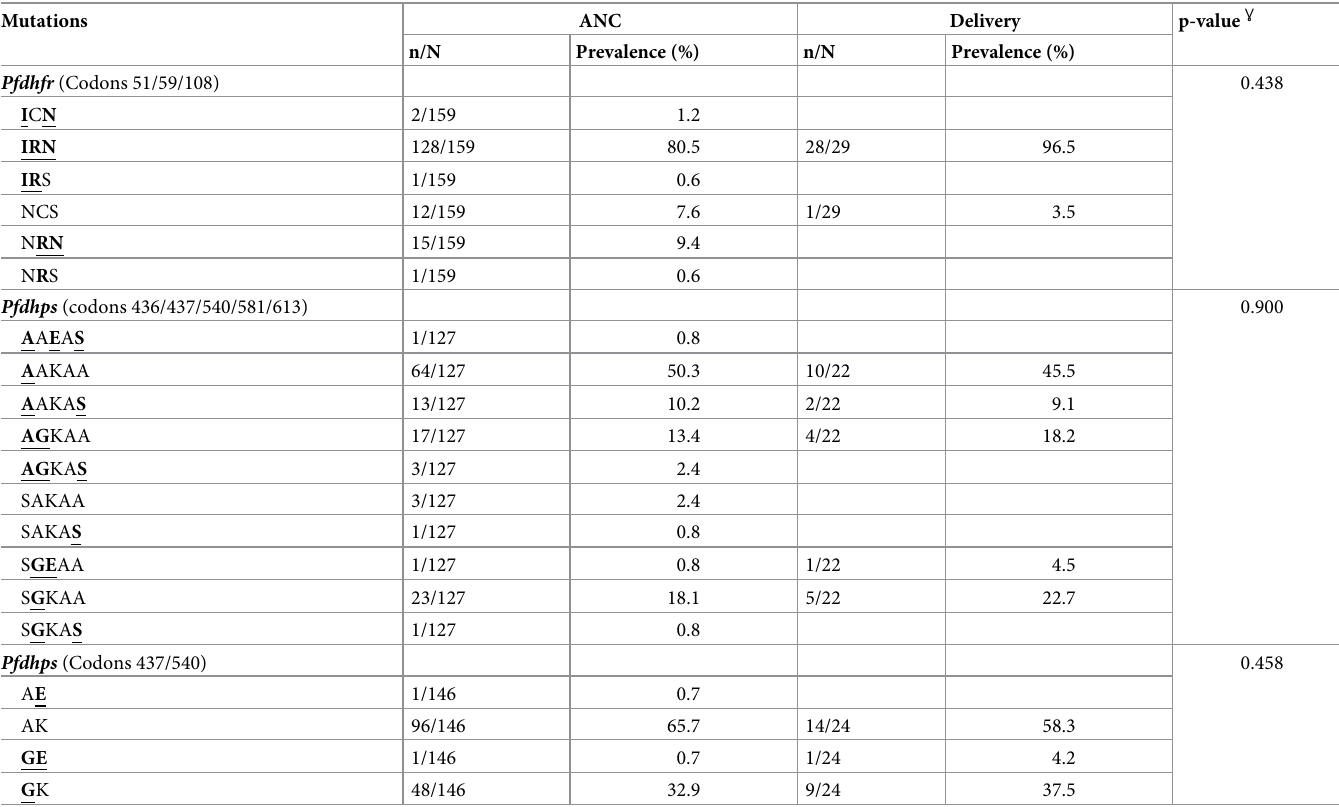
Table 3. Prevalence of Pfdhfr (codons 51/59/108), Pfdhps (codons 437/540) and Pfdhps (codons 436/437/540/581/613) haplotypes at first ANC and at delivery.